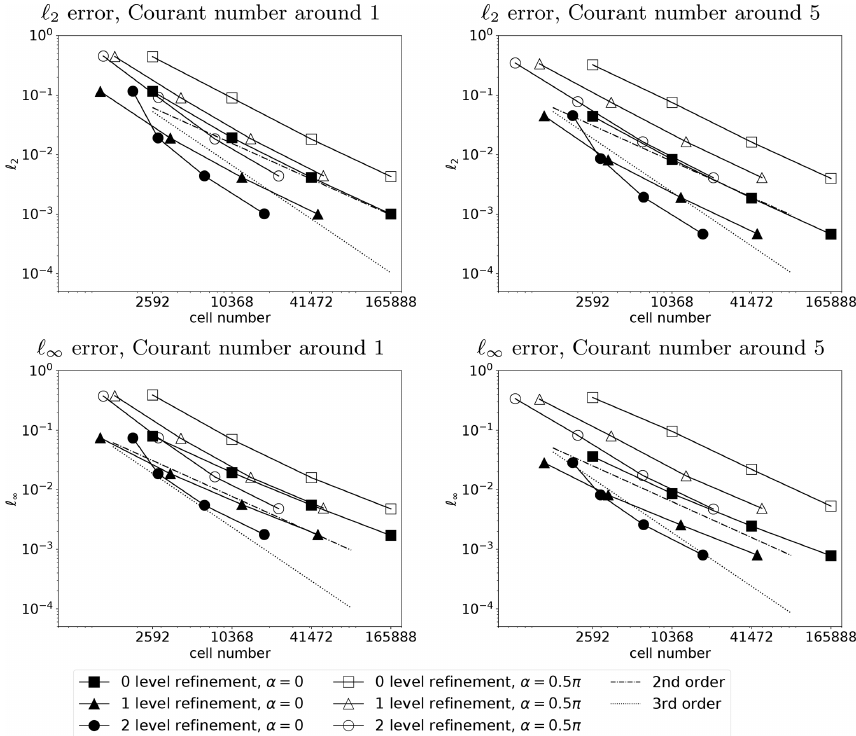
Figure 9. Convergence rate of the numerical results with respect to the number of cells in the solid body rotation test case.